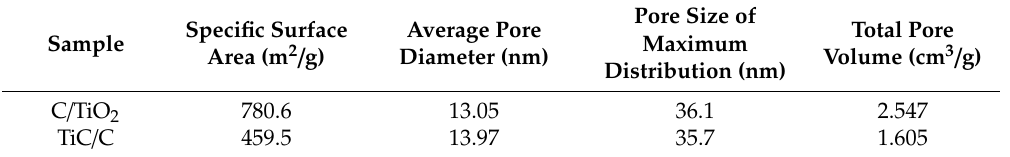
Figure 8. Adsorption and desorption curves and pore size distribution curves of ( a ) C / TiO 2 aerogel and ( b ) TiC / C aerogel. Table 2. Data related to the pore structures of RF / TiO 2 aerogel, C / TiO 2 aerogel and TiC / C